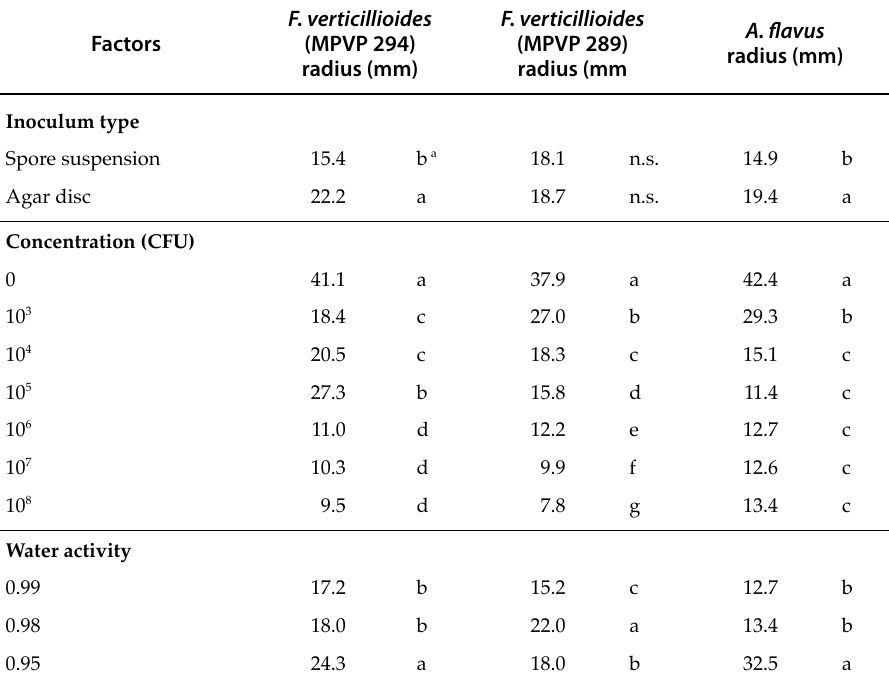
Table 3. Results of ANOVA regarding the effect of Serenade (different concentrations), inoculation method, and water activity on in vitro growth at 25°C of Fusarium verticillioides (MPVP 294 and MPVP 289) and Aspergillus flavus after 14 days of